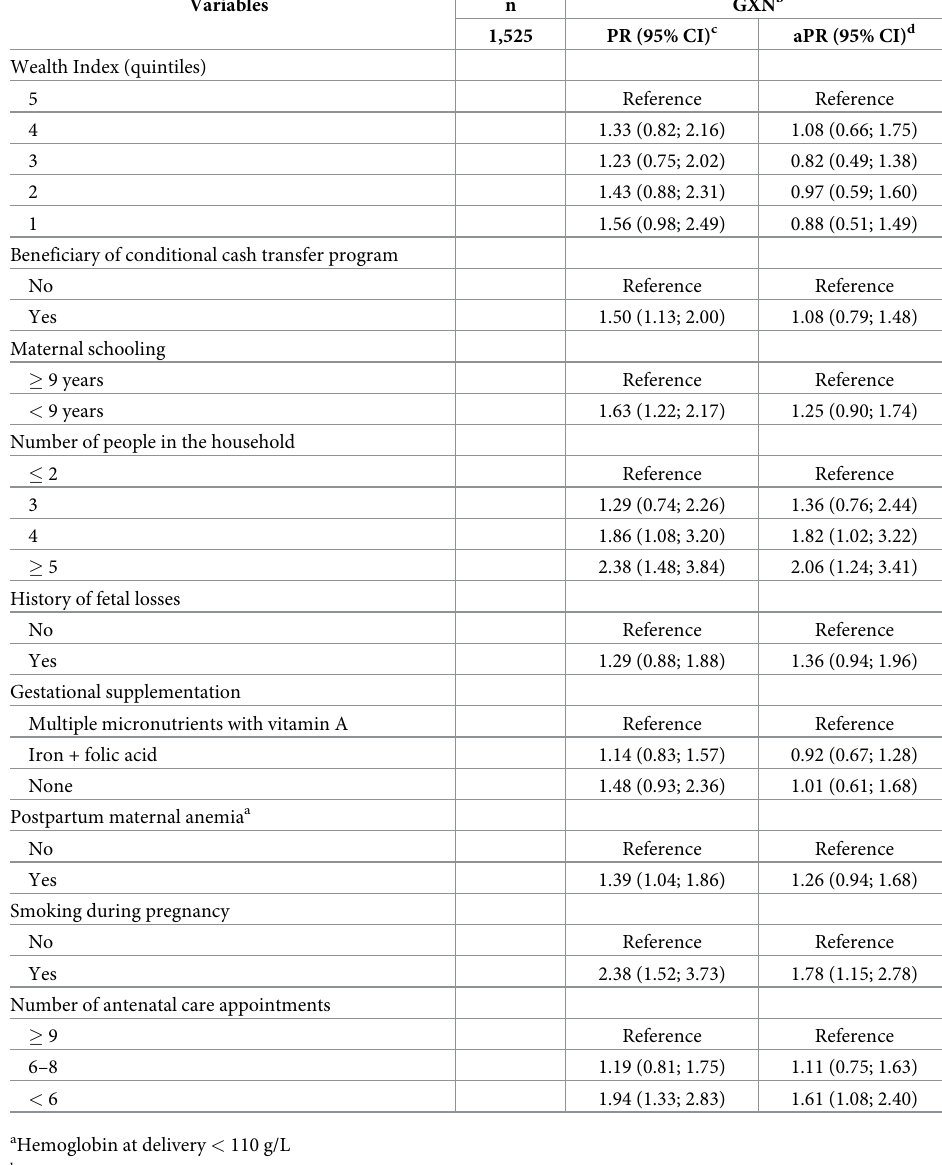
Table 3. Unadjusted and adjusted analysis of associated factors with gestational night